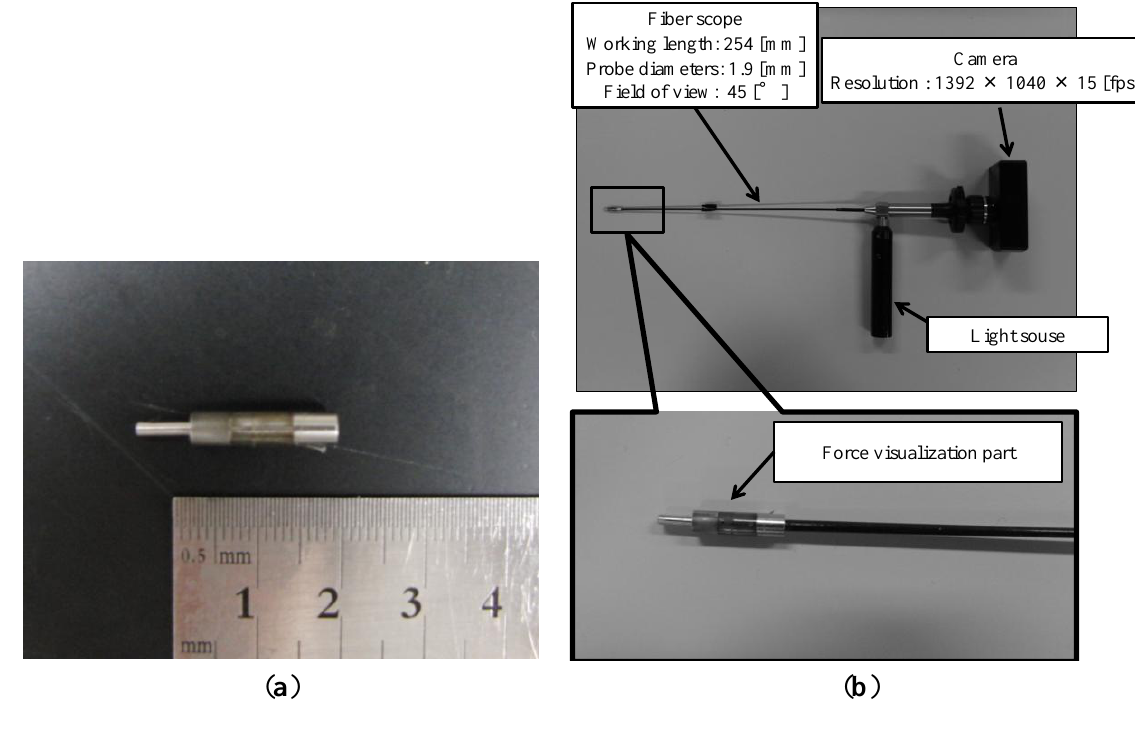
Figure 4. ( a ) Photograph of manufactured force visualization part ( b ) Complete view of developed force sensing system.